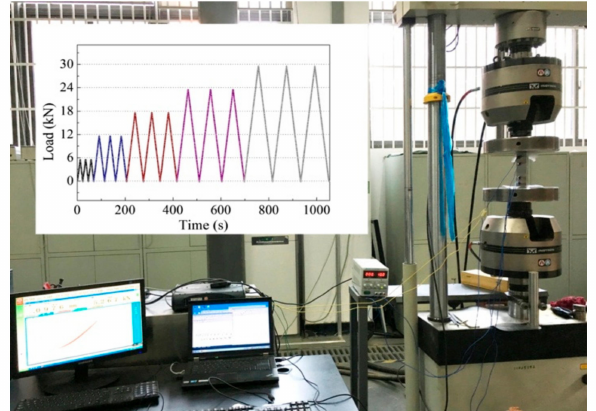
Figure 29. Measurement setup of piezoresistive test of the GNP-added cement mortars under cyclic compressions. Reprinted with permission from [160]. Copyright © 2019, Elsevier